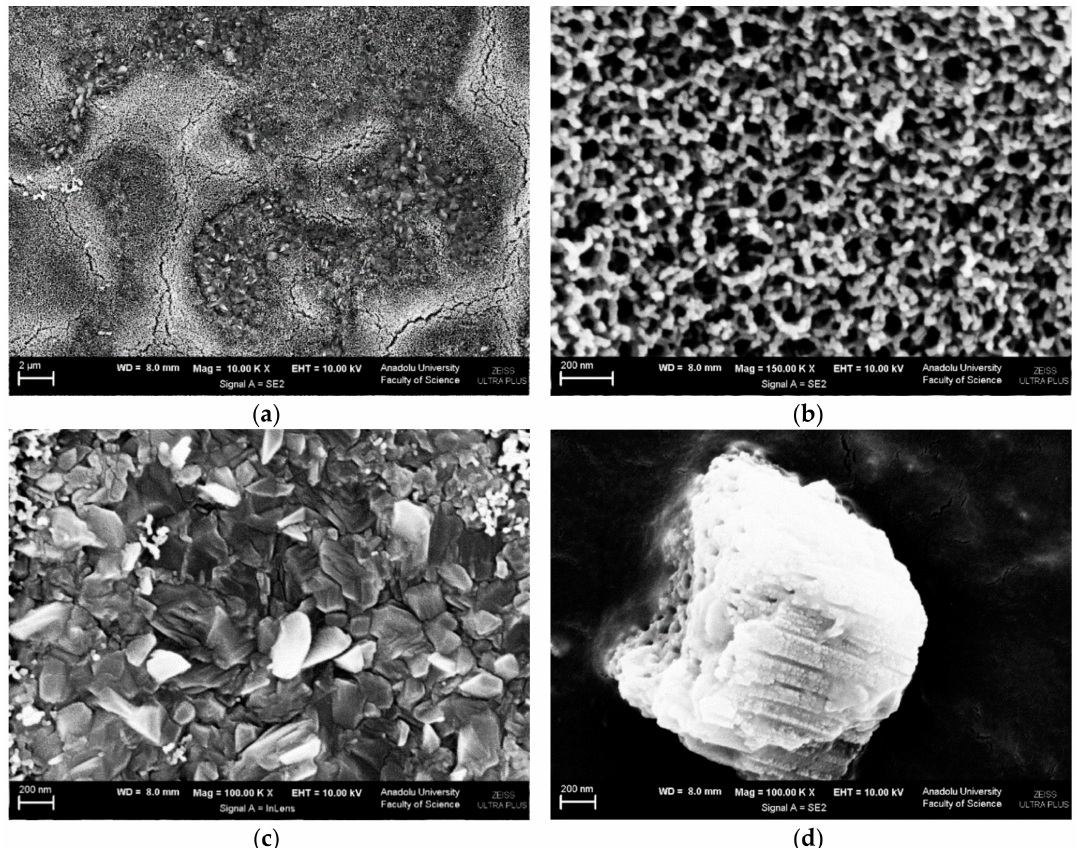
Figure 4. SEM images of Ti/TiO 2 NTHF-6h-650 photoanode: ( a ) top view (magnification: 10,000 × ), ( b ) top view (magnification: 150,000 × ), ( c ) top view (magnification: 100,000 × ) and ( d ) cross-section view (magnification: 100,000 ×